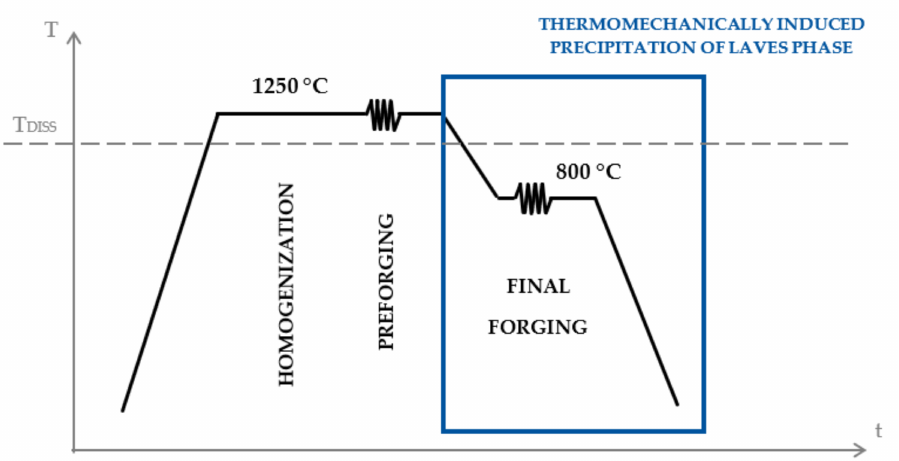
Figure 1. Newly developed thermomechanical processing route of the HiperFer stainless steels with indicated Laves phase dissolution temperature T DISS .